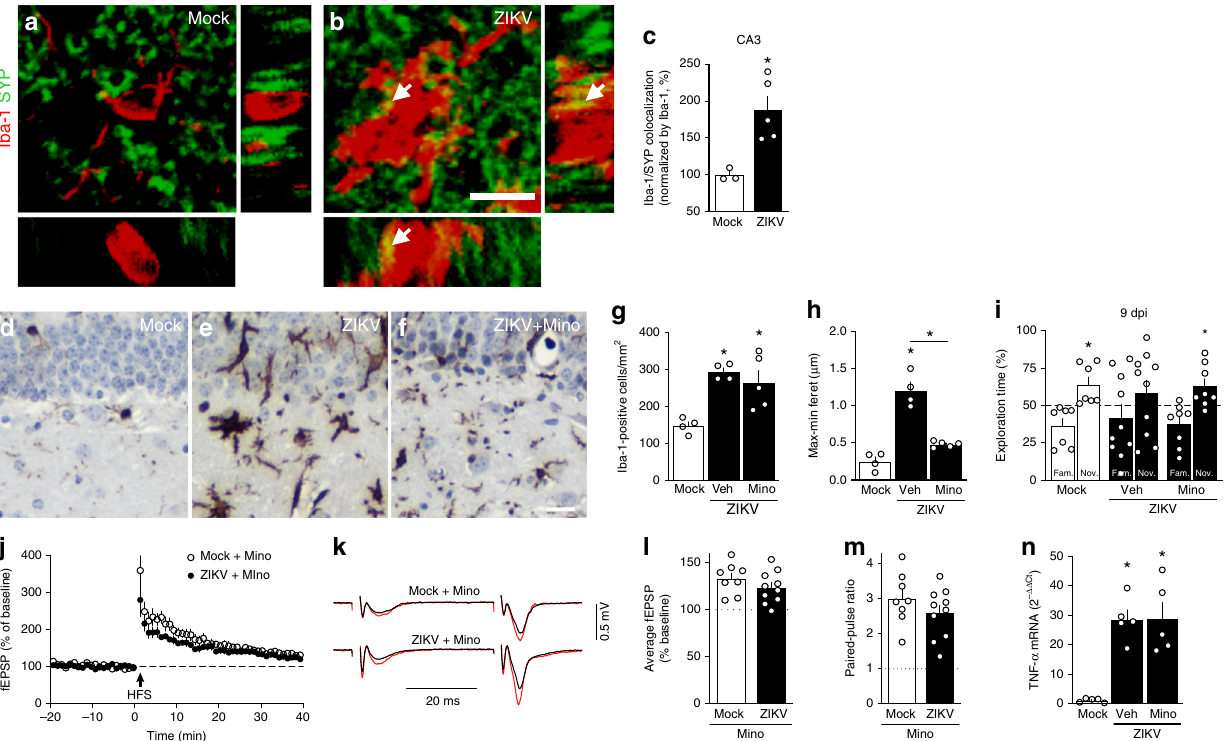
Fig. 5 Microglia mediates ZIKV-induced memory impairment in mice. Adult mice received an i.c.v. infusion of 10 5 PFU ZIKV or mock medium. a , b Representative images of microglia (Iba-1 positive, red) engul fi ng pre-synaptic terminals immunolabeled for pre-synaptic marker synaptophysin (SYP, green) in the hippocampus of mock- ( a ) or ZIKV-infected mice ( b ) at 6 dpi. White arrows point to SYP-positive elements engulfed within microglia. Scale bar = 20 μ m. c Quanti fi cation of microglia-SYP colocalization (t = 3.502, * p = 0.0128; N = 3 (mock) and 5 (ZIKV)). d – n Mice were treated with minocycline (Mino; 50 mg/kg i.p., 3 times/week beginning one week prior to infection). d – f Representative images of Iba-1 immunoreactivity